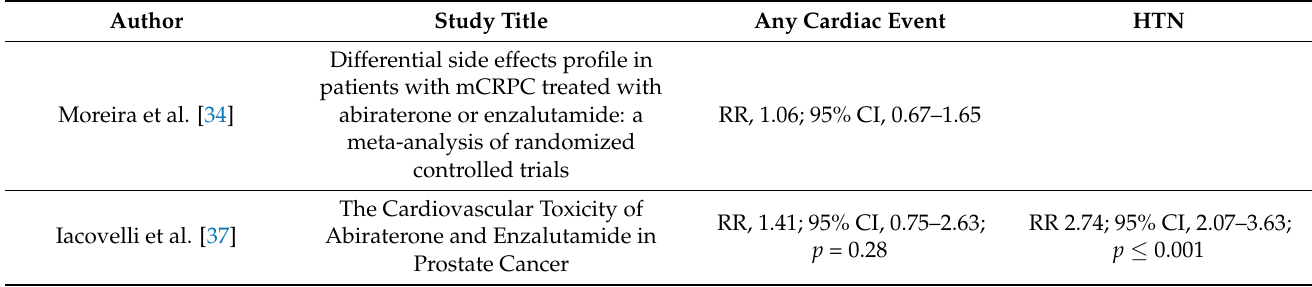
Table A4. CV Adverse Effects in Patients Receiving Enzalutamide or Abiraterone vs. No